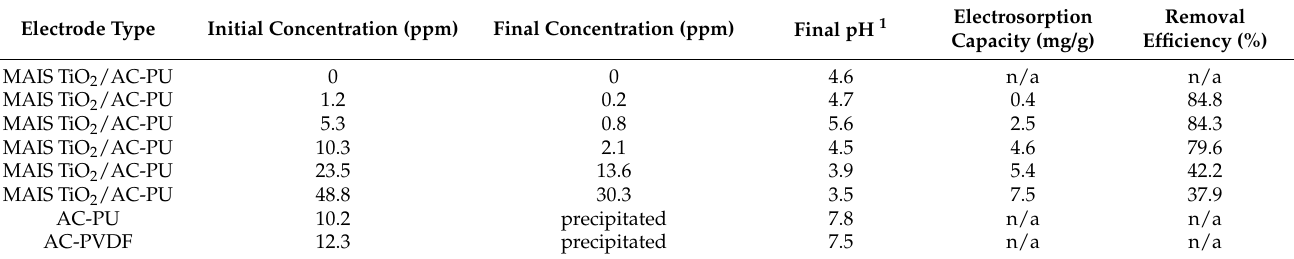
Table 3. Removal efficiency of indium ions using different electrode materials in batch experiments of CDI. Electrode